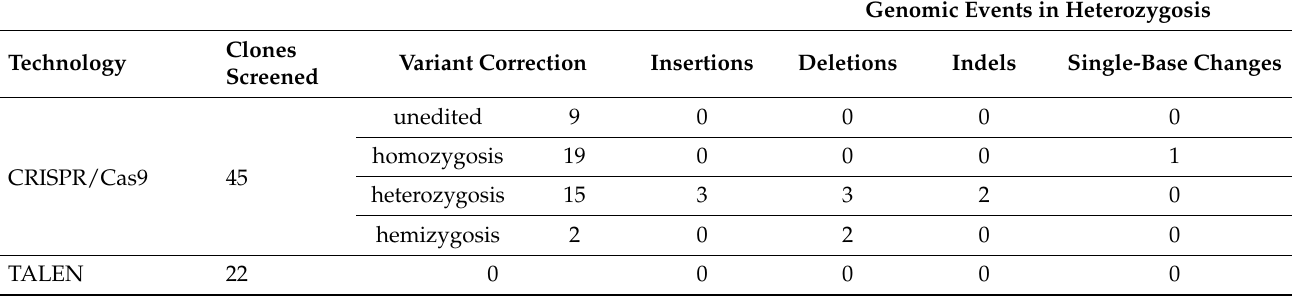
Genomic Events in